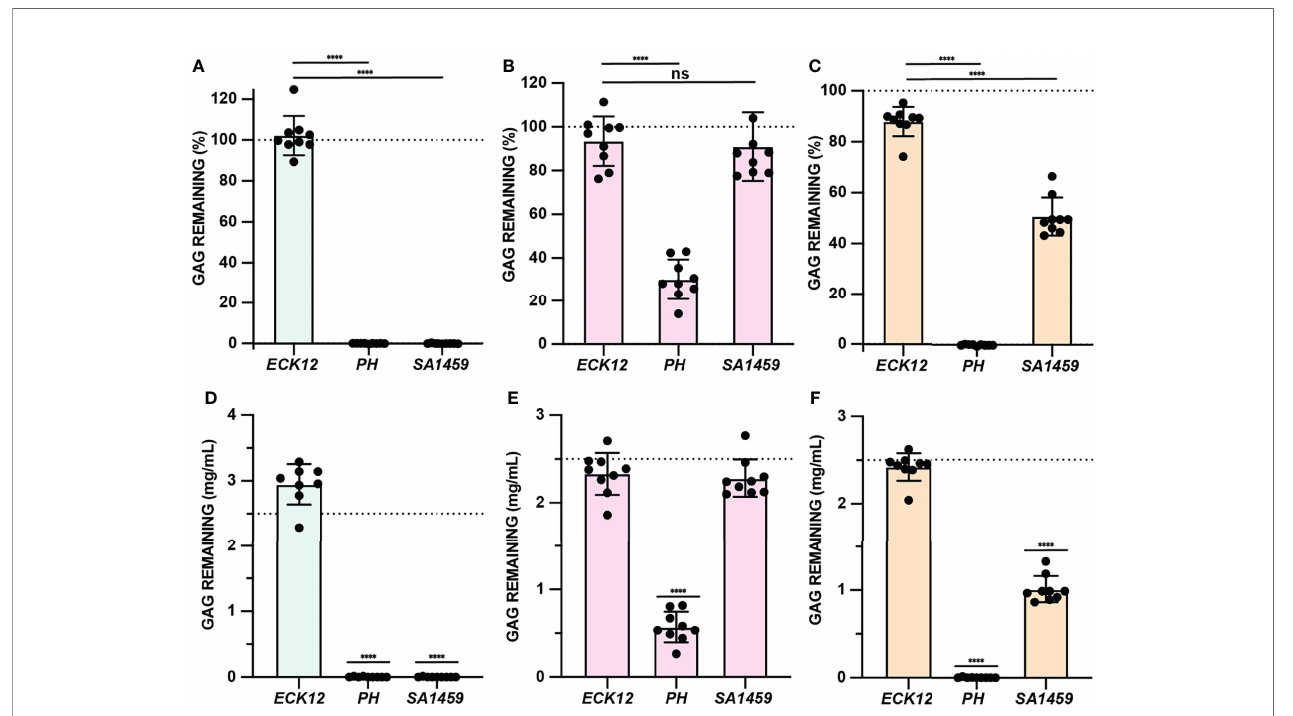
FIGURE 4 | GAG degradation assay validation. (A – C) GAG degradation assays were performed and semiquantitative GAG remaining values were shown for ECK12, PH, and SA1459 in basal media supplemented with HA (light blue), HP (light pink), and CS (light tan). An ordinary one-way ANOVA with Dunnett ’ s Multiple Comparisons Test was utilized to compare the GAG activity of negative control ECK12 with PH and SA1459. Dotted line represents a 100% theoretical threshold signifying no GAG degradation. (D – F) Absolute abundances of GAGs were interpolated from experimentally generated standard curves and used to assess HA (light blue), HP (light pink), and CS (light tan) degradation in basal media. An ordinary one-way ANOVA with Dunnett ’ s Multiple Comparisons Test was performed to compare interpolated GAG concentrations with a 2.5mg/mL baseline GAG pre-incubation concentration (dotted line). Statistically signi fi cant values 1.5 times above baseline are shown (**** p < 0.0001, ns, not signi fi